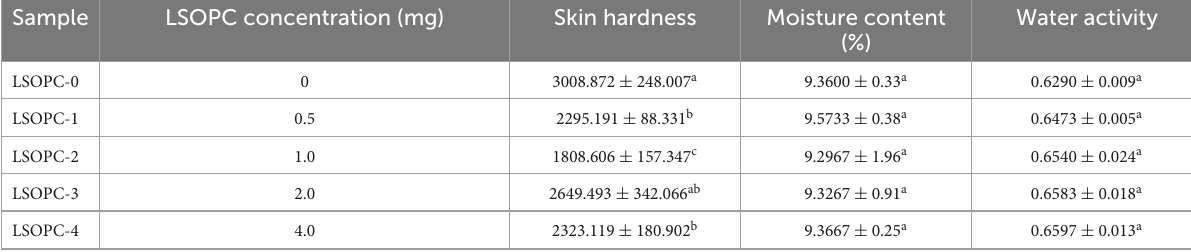
TABLE 1 The effect of LSOPC on the color and skin hardness of the cookies system ( p < 0.05). Sample LSOPC concentration (mg) Skin hardness Moisture content